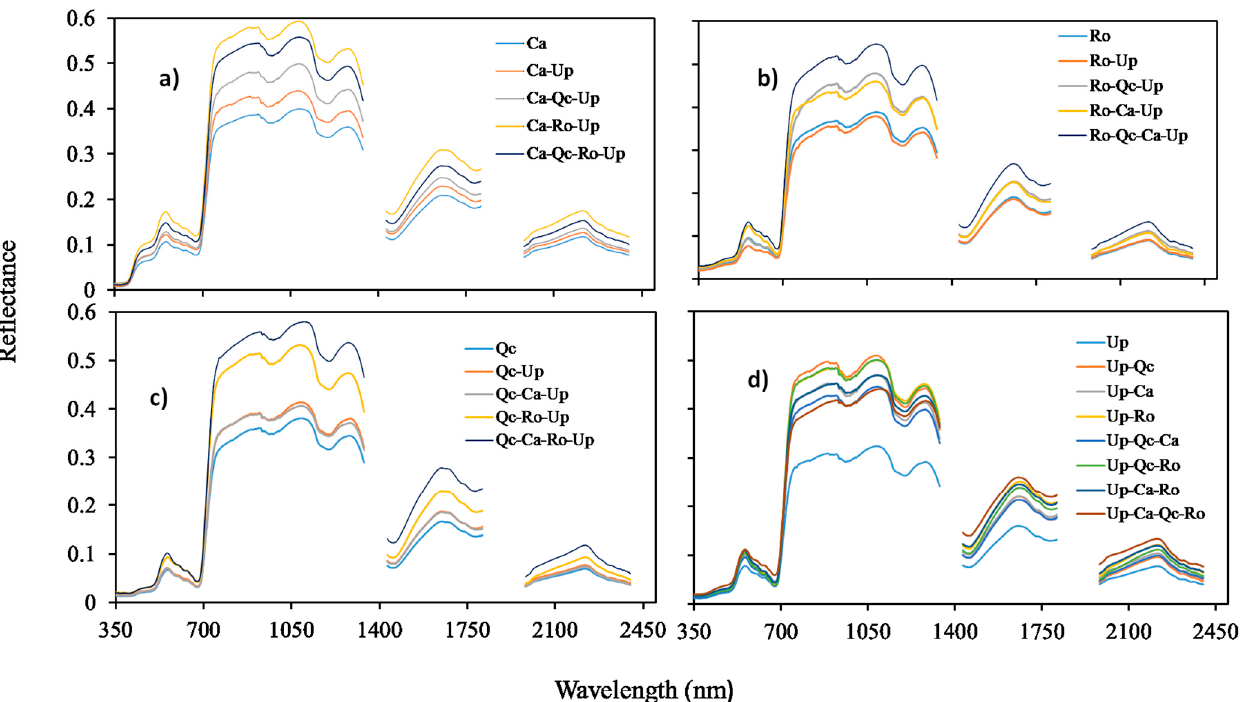
Figure 4. Reflectance spectra in control. ( a ) Cistus albidus (Ca); ( b ) Rosmarinus officinalis (Ro); ( c ) Quercus coccifera (Qc); ( d ) Ulex Parviflorus (Up) in monospecific stands. Bispecific (Ca-Up; Ro-Up; Qc-Up; Up-Ca; Up-Ro; Up-Qc), trispecific (Ca-Qc-Up; Ca-Ro-Up; Qc-Ca-Up; Qc-Ro-Up; Ro-Qc-Up; Ro-Ca-Up; Up-Qc-Ca; Up-Qc-Ro; Up-Ca-Ro) and tetraspecific stand (Ca-Qc-Ro-Up; Qc-Ca-Ro-Up; Ro-Qc-Ca-Up; Up-Qc-Ca-Ro). The first two letters of each assemblage indicate the species on which the measurements were performed. Means, n = 27.